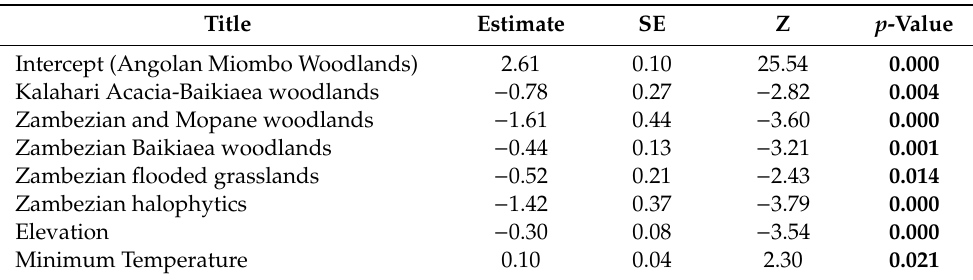
Table 2. Final (and global) generalized linear mixed model testing the relationship between the bat species richness in each grid cell and the terrestrial ecoregions, elevation and temperature in the Okavango Basin of Angola, Namibia and Botswana (significance level of bold p < 0.05).